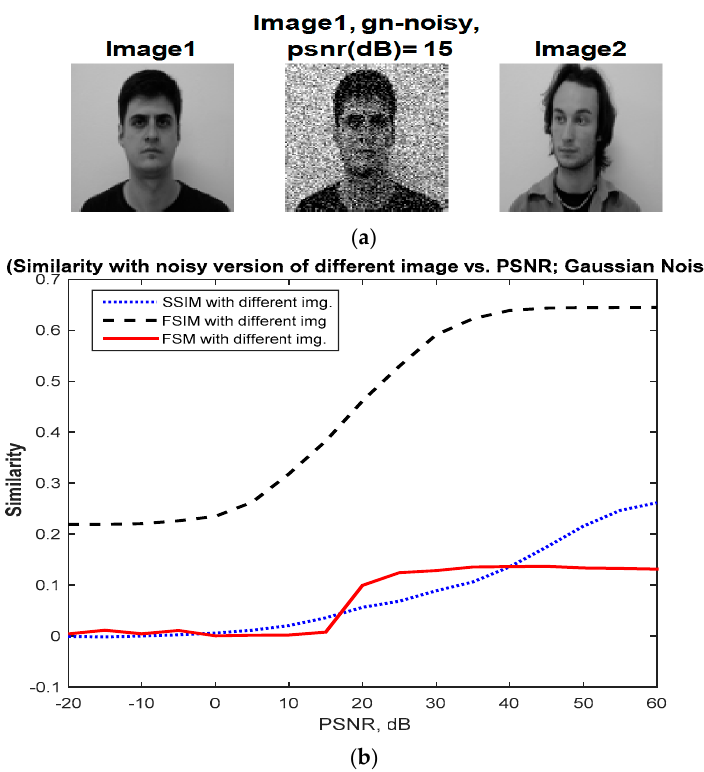
Figure 18. Performance of similarity measures using dissimilar images under Gaussian noise; ( a ) Above: The test images; ( b ) Performance of SSIM, FSM and FSIM under Gaussian noise.